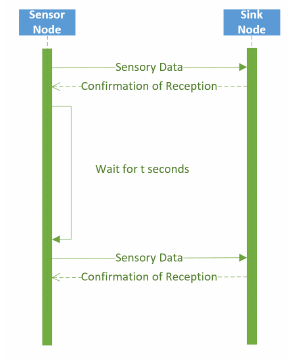
Figure 7. Passive wireless sensor node communication with the sink